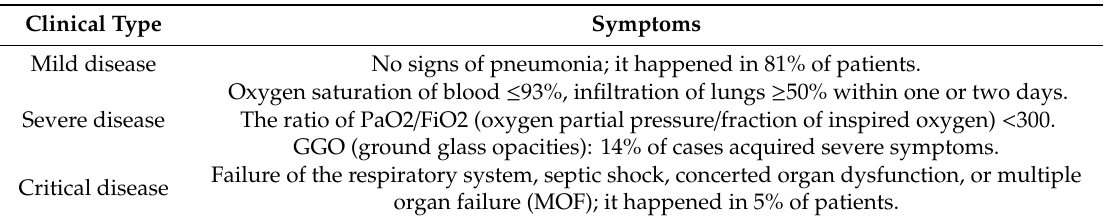
Table 2. Clinical symptoms integrated with the severity of COVID-19 [48,66].